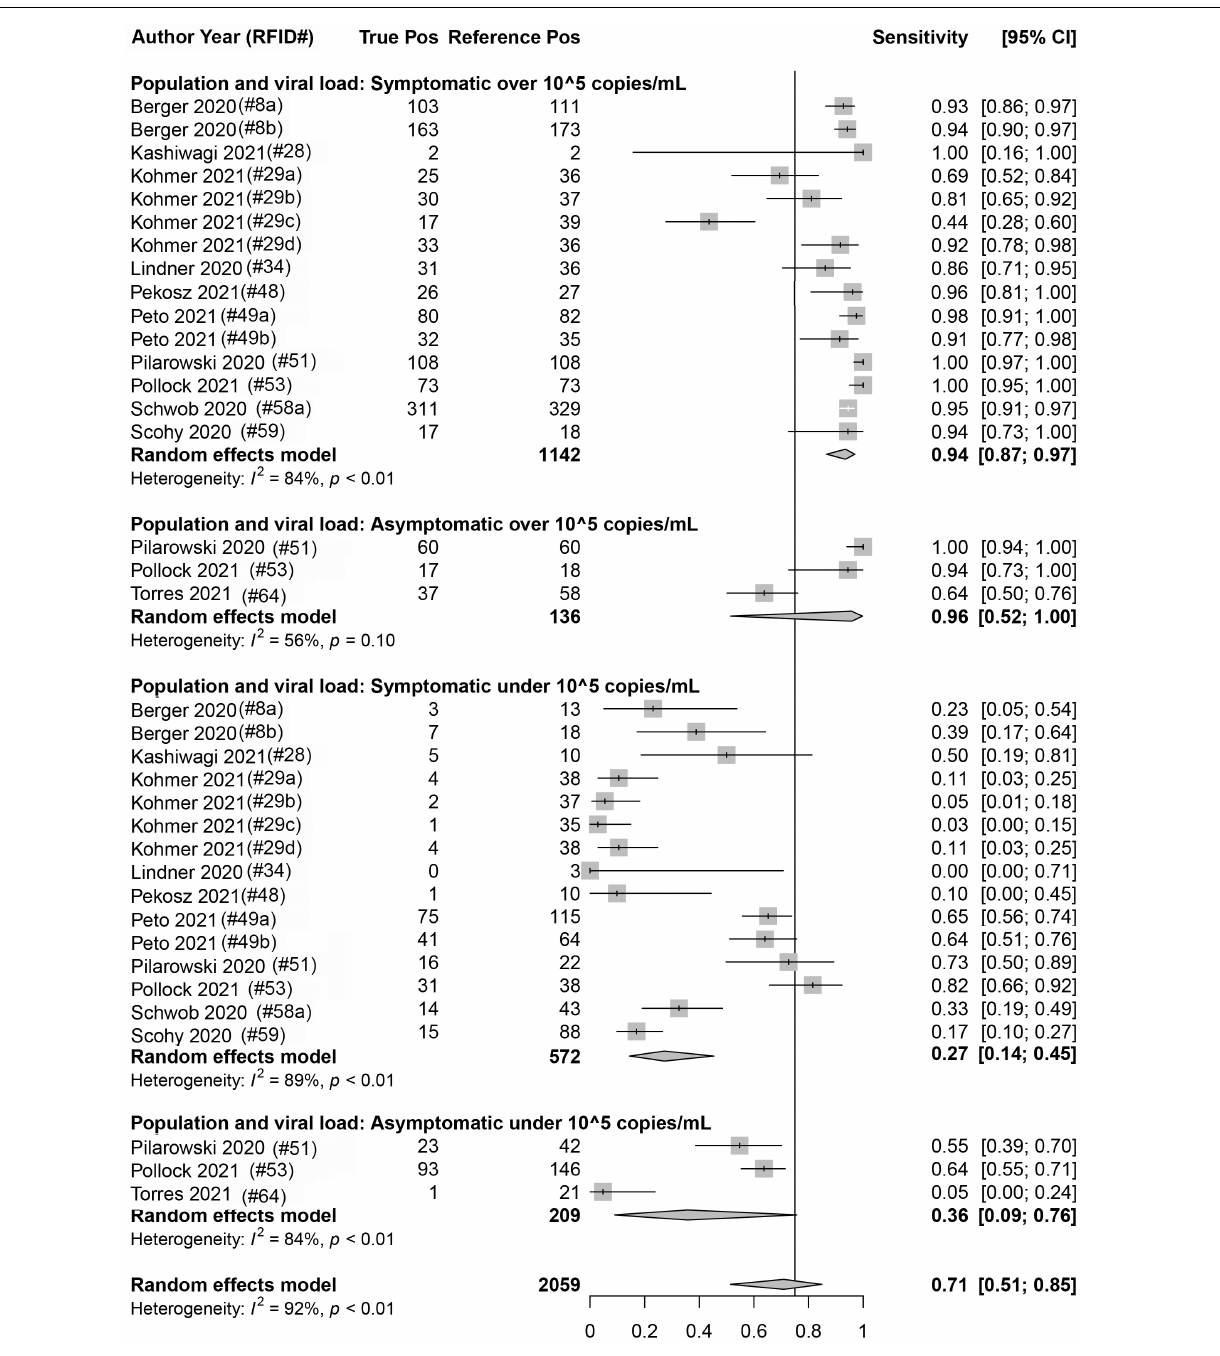
FIGURE 5 | Forest plots containing calculated sensitivity values for index [severe acute respiratory syndrome coronavirus-2 (SARS-CoV-2) antigen test] testing compared to reference [SARS-CoV-2 quantitative reverse transcription polymerase chain reaction (RT-qPCR assay)] test. Data are stratified by viral load [genomic copies/ml (cpm)] and by symptomatic or asymptomatic